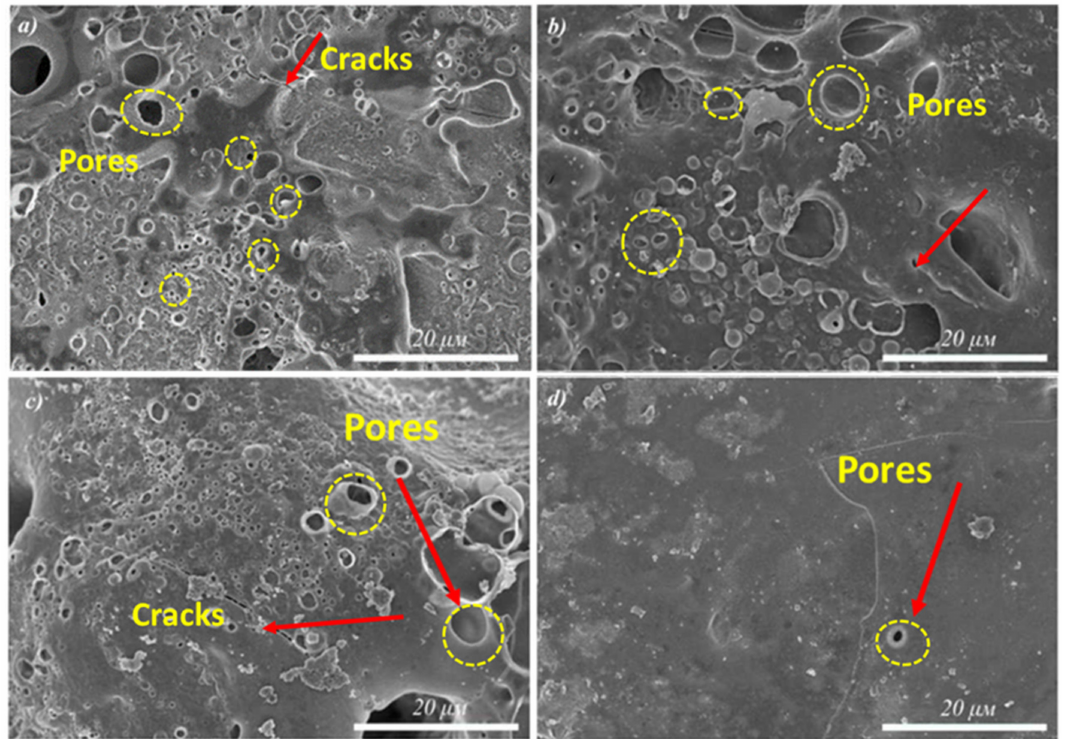
Figure 2. SEM images of the surface morphologies of the PEO-coated samples formed under different current densities of ( a ) 8.8 A/dm 2 , ( b ) 13.5 A/dm 2 , ( c ) 17.8 A/dm 2 , and ( d ) 22.3 A/dm 2